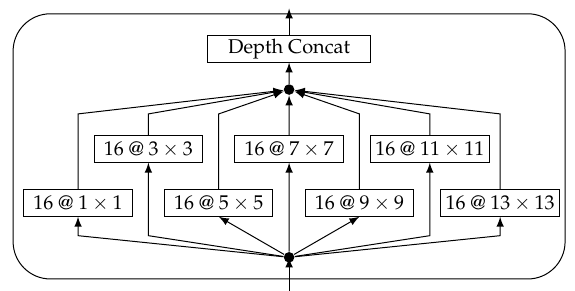
Figure 3. Inception-like module that is used as the first convolutional layer. The notation “16 @ 3 × 3” implies 16 filter kernels with a spatial extent of 3 × 3. All layers use same padding and a stride of 1. We use seven branches with different kernel sizes and the same number of kernels for each branch.